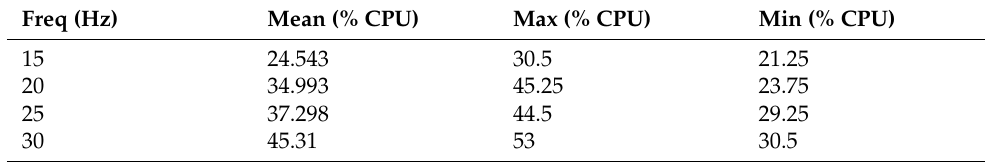
Table 4. Mean-resolution CPU usage